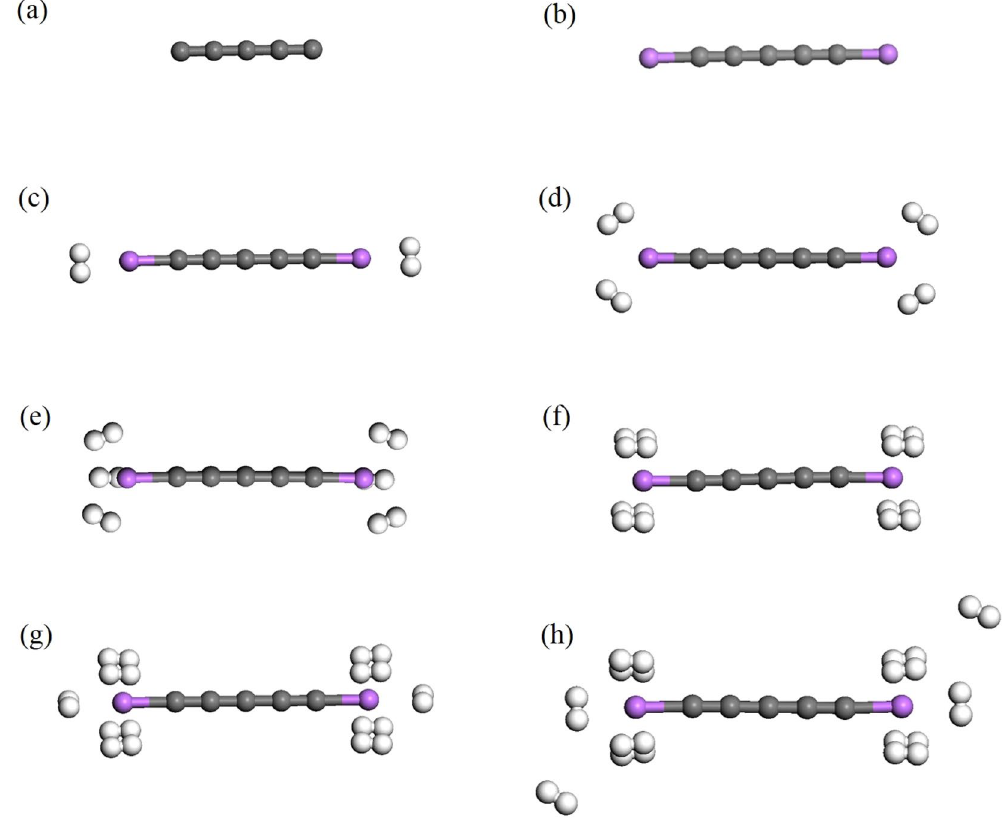
Figure 1. Structures of ( a ) C 5 , ( b ) Li 2 C 5 , ( c ) Li 2 C 5 with one H 2 molecule adsorbed on each Li atom, ( d ) Li 2 C 5 with two H 2 molecules adsorbed on each Li atom, ( e ) Li 2 C 5 with three H 2 molecules adsorbed on each Li atom, ( f ) Li 2 C 5 with four H 2 molecules adsorbed on each Li atom, ( g ) Li 2 C 5 with five H 2 molecules adsorbed on each Li atom, and ( h ) Li 2 C 5 with six H 2 molecules adsorbed on each Li atom. Here, grey, white, and purple balls represent C, H, and Li atoms,